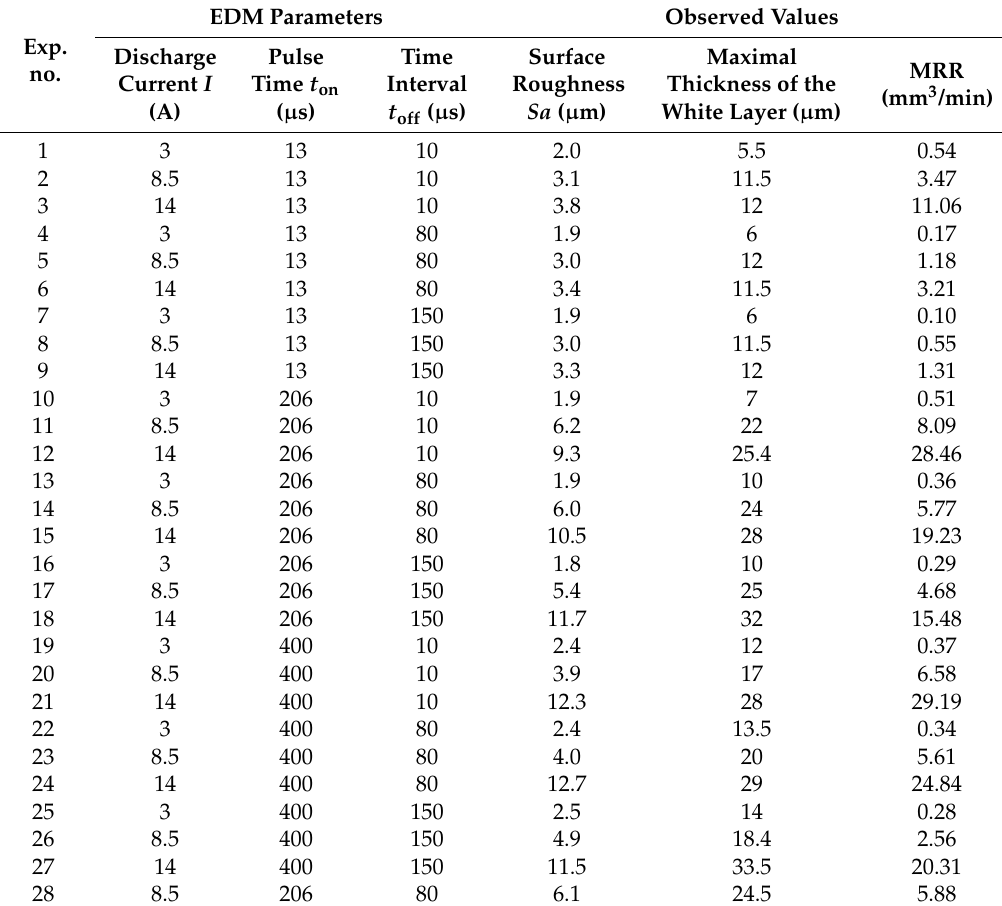
Table 5. The design of the experimental